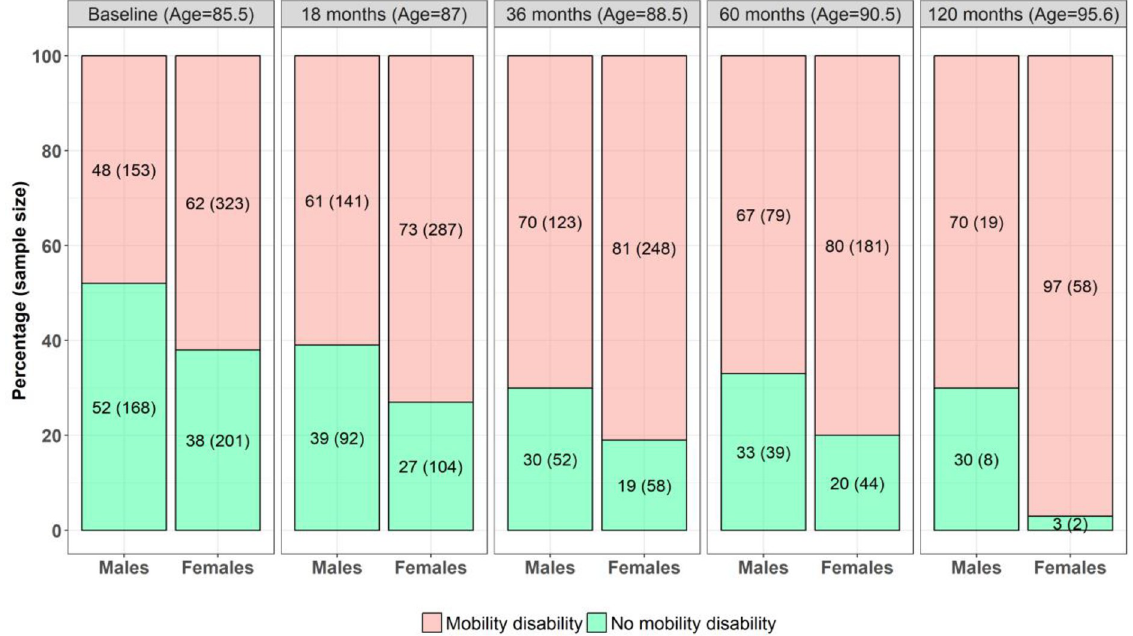
Fig 2. Prevalence of self-reported mobility disability in male and female participants from age 85–95. Note: ages represent mean ages.